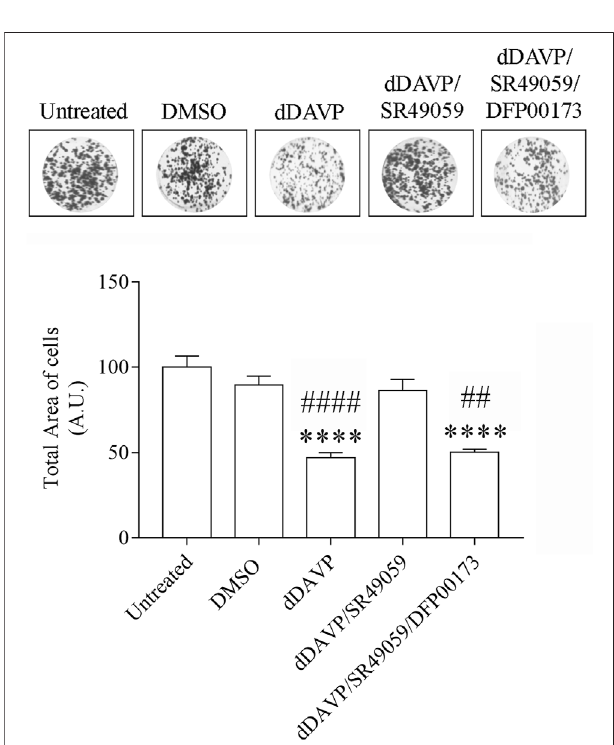
FIGURE 11 | Effect of AQP3 on cell growth. Cells were left under basal conditions or treated as described in the methods section, stained with 0.2% Coomassie Bluesolution,and thetotal areaofthe growth cellswasmeasured usingMetamorphsoftware.Comparedtountreatedcells,treatmentwith 2.5 µM DFP00173 for 48 h prevented the SR49059 action on dDAVP treatment. Data are presented as means ± S.E.M. of 3 independent experiments andanalyzedbyone-wayANOVA followed byDunnett ’ sMultiple Comparison test (**** p < 0.0001 vs. untreated; ## p < 0.01 and #### p < 0.0001 vs.